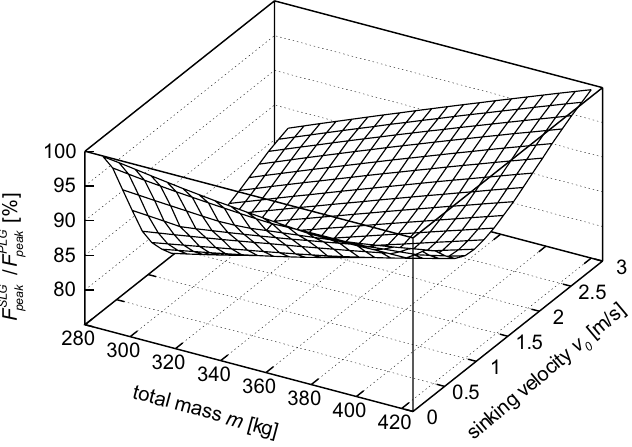
Fig. 8. SLG compared to PLG, relative improvement: Computed ratio of the peak strut force in the optimally controlled SLG to the peak strut force in PLG at the same landing conditions, in dependence on the total mass m and sinking velocity v 0 . highest-energy landing scenario (i.e. at the highest mass m max ), A V D − SLG o ( v 0 ) := A SLG o ( m max , v 0 )